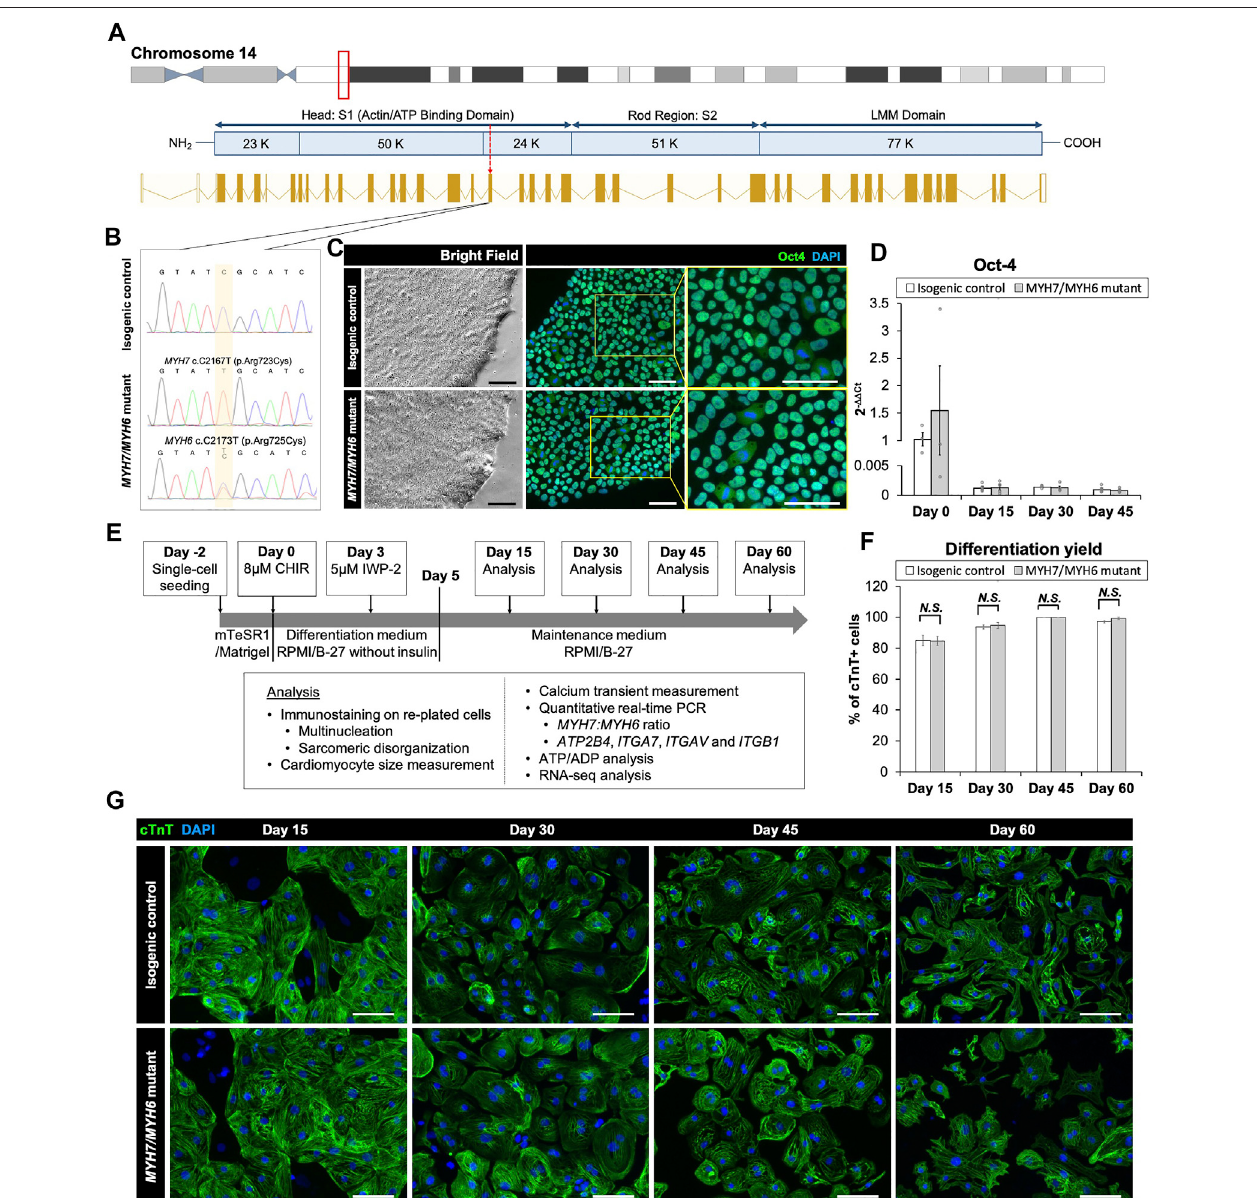
FIGURE 1| Base editing and characterizationofthe MYH7/MYH6 mutant hiPSCs. (A) Schematic of MYH7 locusas shown in the red box on chromosome14 and c.2167locationaspointedbytheredarrowforbaseediting. (B) Chromatogram of MYH7 mutantlocusinhiPSCsshowingc.C2167T(p.Arg723Cys, p.R723C)mutation and its isogenic parental genotype. (C) Bright fi eld images and immunostaining of Oct-4 using the isogenic control and MYH7/MYH6 mutant hiPSCs. DAPI labels the nuclei(blue). (D) qPCRanalysisforOct-4expressionlevelusingRNAisolatedfromtheisogeniccontroland MYH7/MYH6 mutanthiPSCs. (E) Cardiacdifferentiation timelineandanalysisregime. (F) Quantitativeanalysisofthedifferentiationef fi ciencybasedonthecTnTstaininginthecontroland MYH7/MYH6 mutantcardiomyocytes. Note that mutation did not result in any signi fi cant difference in the cardiomyocyte differentiation ef fi ciency. (G) Cardiac Troponin T (cTnT) and DAPI-stained hiPSC-CMs on Day 15, 30, 45, and 60 after the start of differentiation. Data represents mean ± SEM. (Scale Bar = 100 μ m) ( N.S. : not signi fi cant; Student t test).